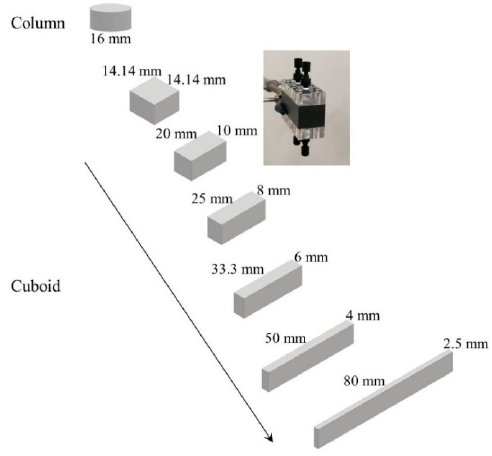
Figure 2. Dimensions of the different cuboid packed-bed devices and their equivalent column. Inset photograph: assembled 20 mm × 10 mm × 25 mm device. Inset photograph: assembled 20 mm × 10 mm × 25 mm